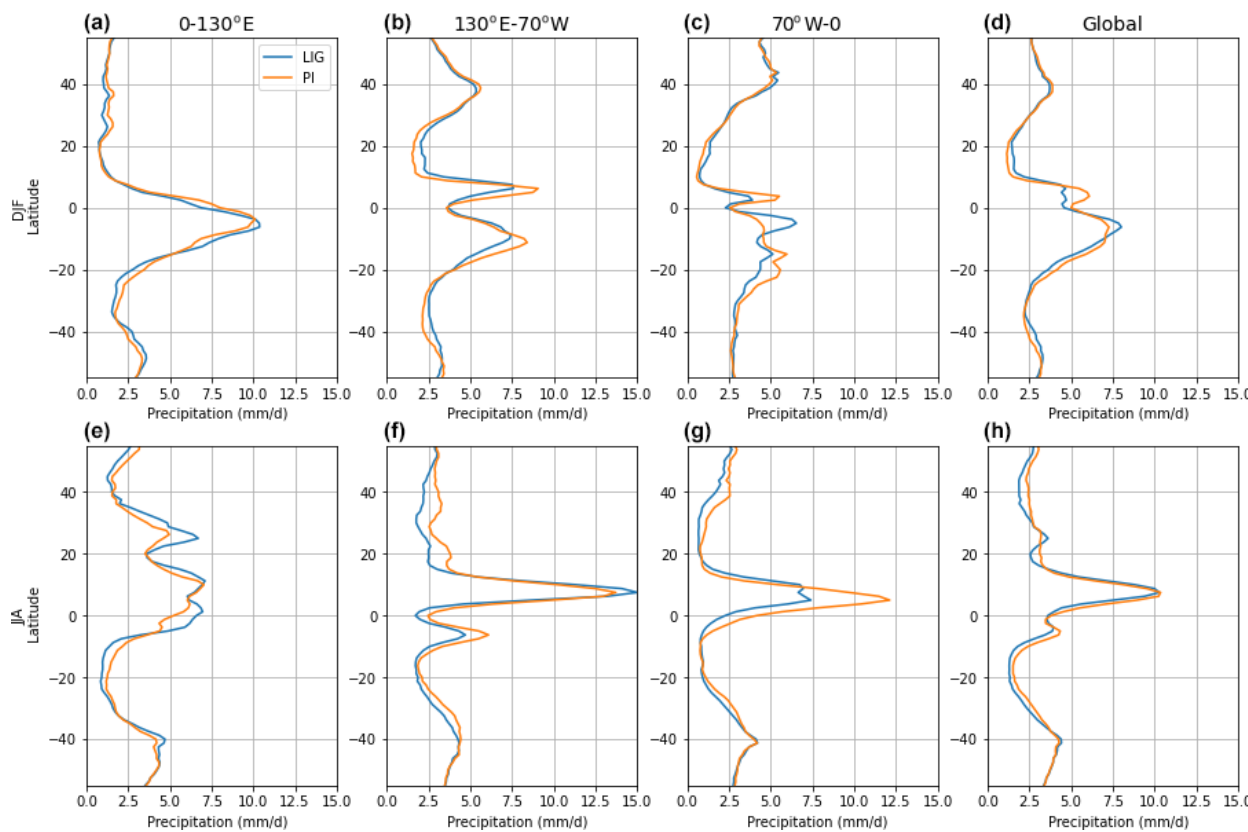
Figure 5. Zonally averaged precipitation (mmd − 1 ). 0–130 ◦ E covers most of Africa, Indian Ocean and up to western Australia; 130 ◦ E– 70 ◦ W covers the Pacific Ocean, and 70 ◦ W–0 ◦ covers the central part of Atlantic Ocean. (a–d) DJF; (e–h)